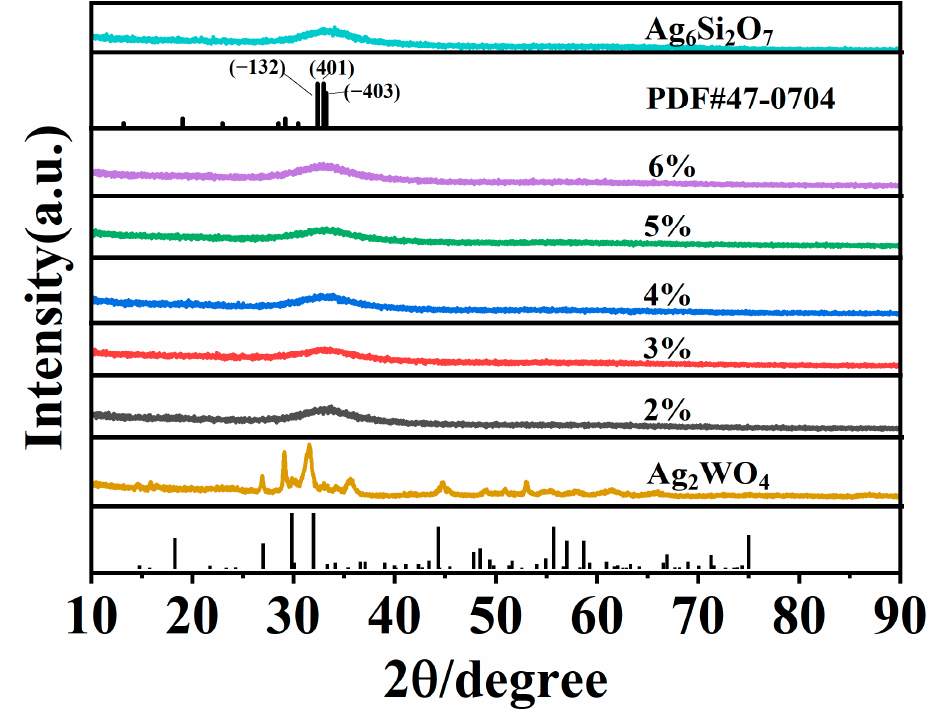
Figure 1. XRD patterns of Ag 2 WO 4, Ag 6 Si 2 O 7 , and Ag 6 Si 2 O 7 /Ag 2 WO 4 (2%, 3%, 4%, 5%, and